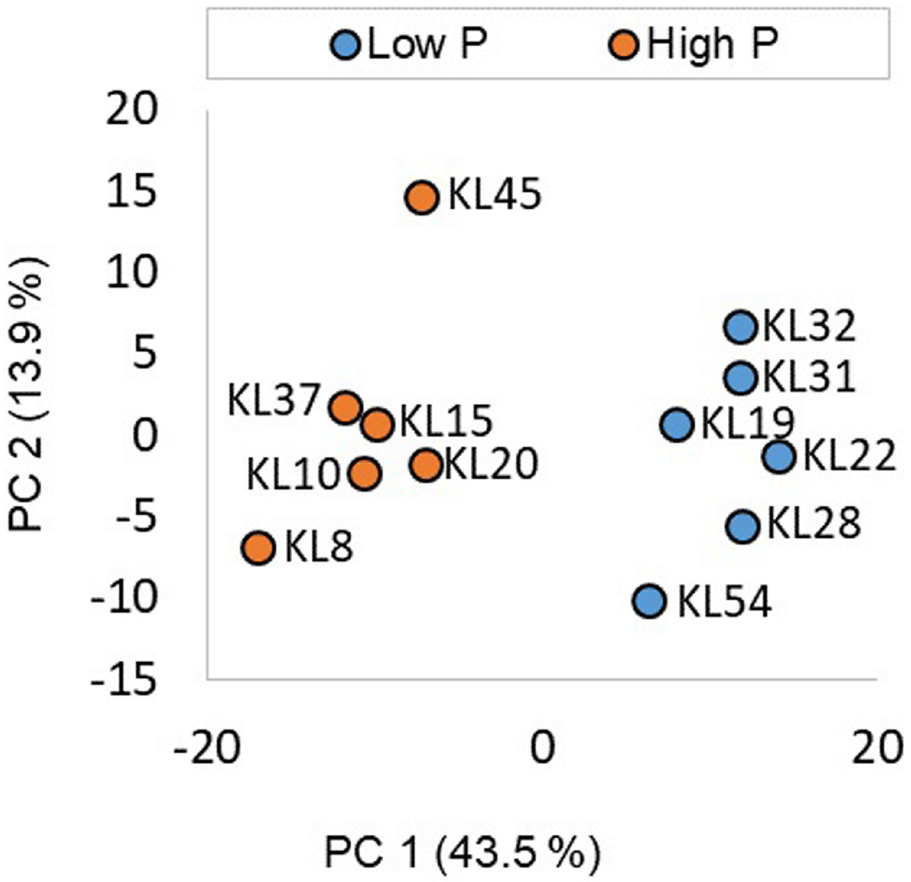
Fig 1. Principal component analysis of the total lipidome of samples with high phosphorous content (orange) versus samples with low phosphorous content (blue). Data was normalized by sum, log transformed and mean centered. PC1 explained 43.5% of the variation, and PC2 explained 13.9% of the variation.